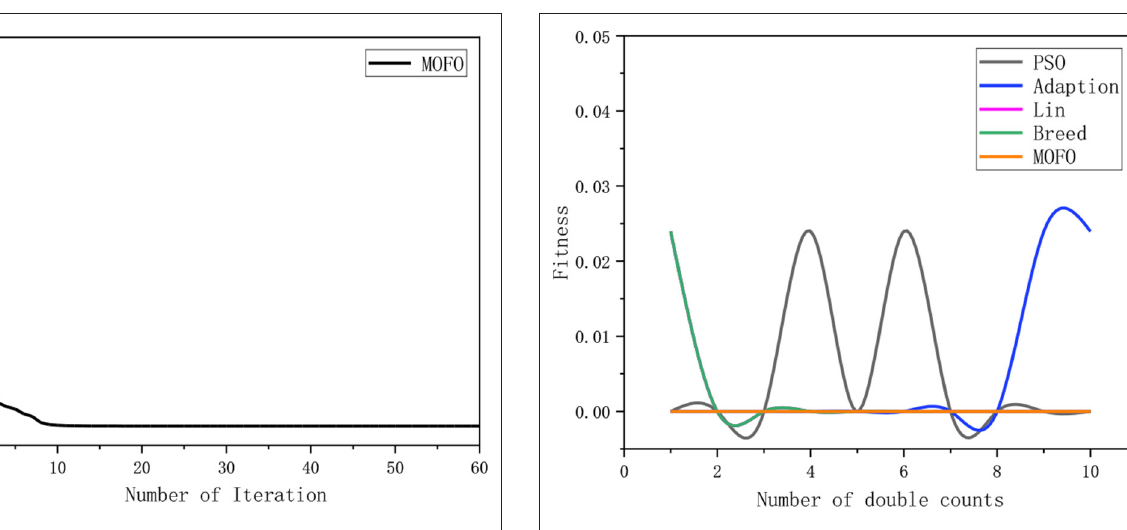
convergence speed, while the MOFOPSO is better than the RWPSO at a close speed. From the vertical axis of the image, it can be seen that the fitness function value of the MOFOPSO algorithm rapidly decreases from the large value to the optimal value. This meets the design goal of balancing the global and local search capabilities of the algorithm.